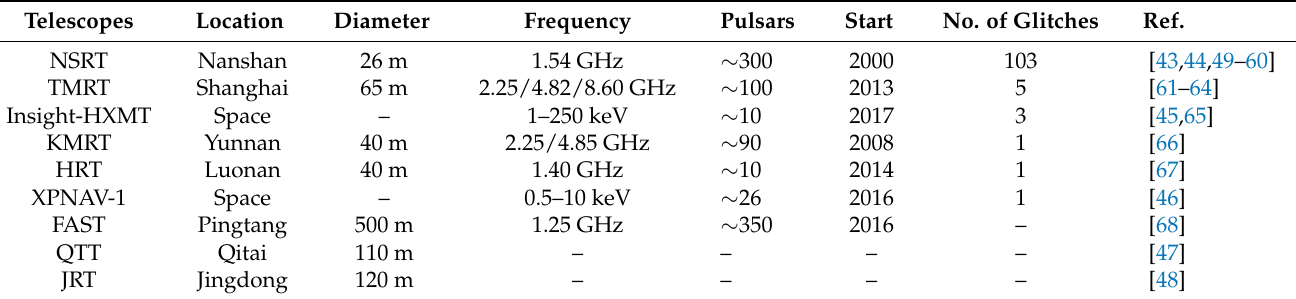
Table 1. Chinese telescopes to perform a search for glitch